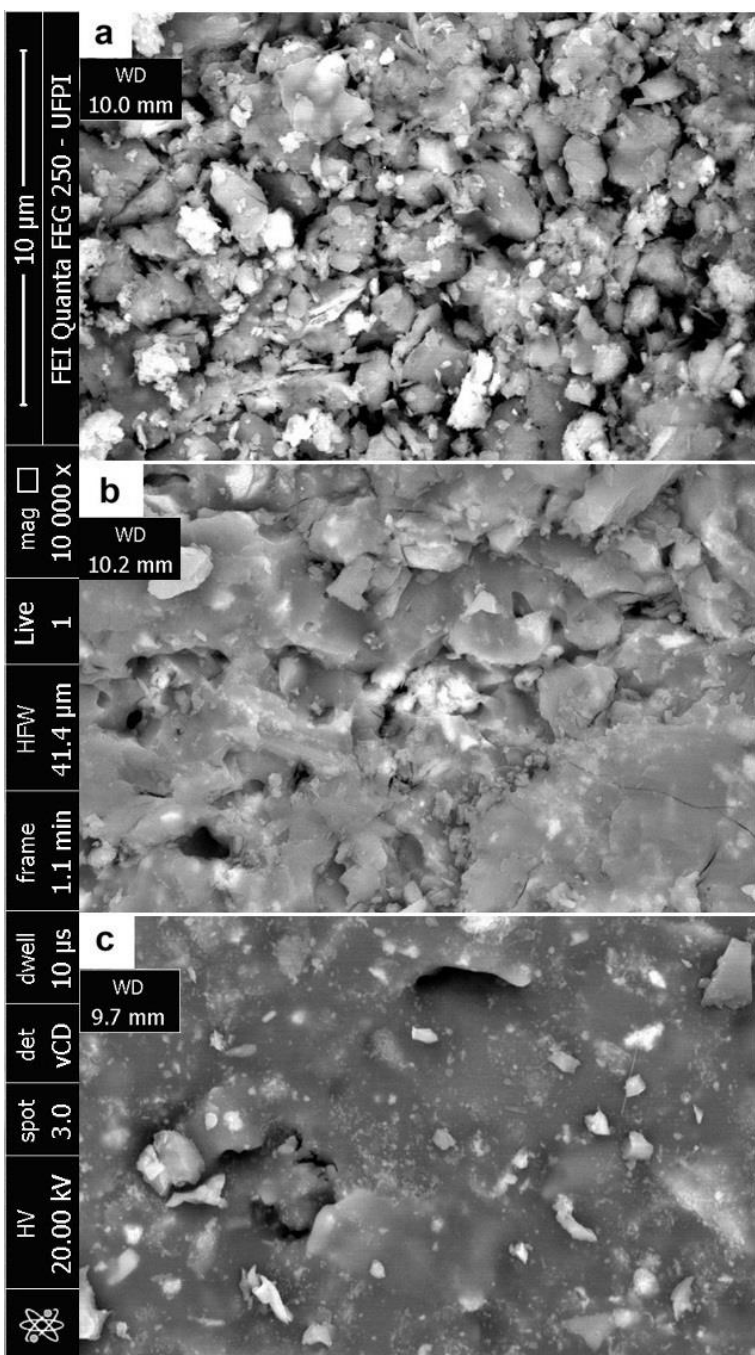
Figure 12. Scanning microscopy at 10,000× magnification: ( a ) sintering image at 1000 °C; ( b ) sintering image at 1100 °C; ( c ) sintering image at 1150 °C.